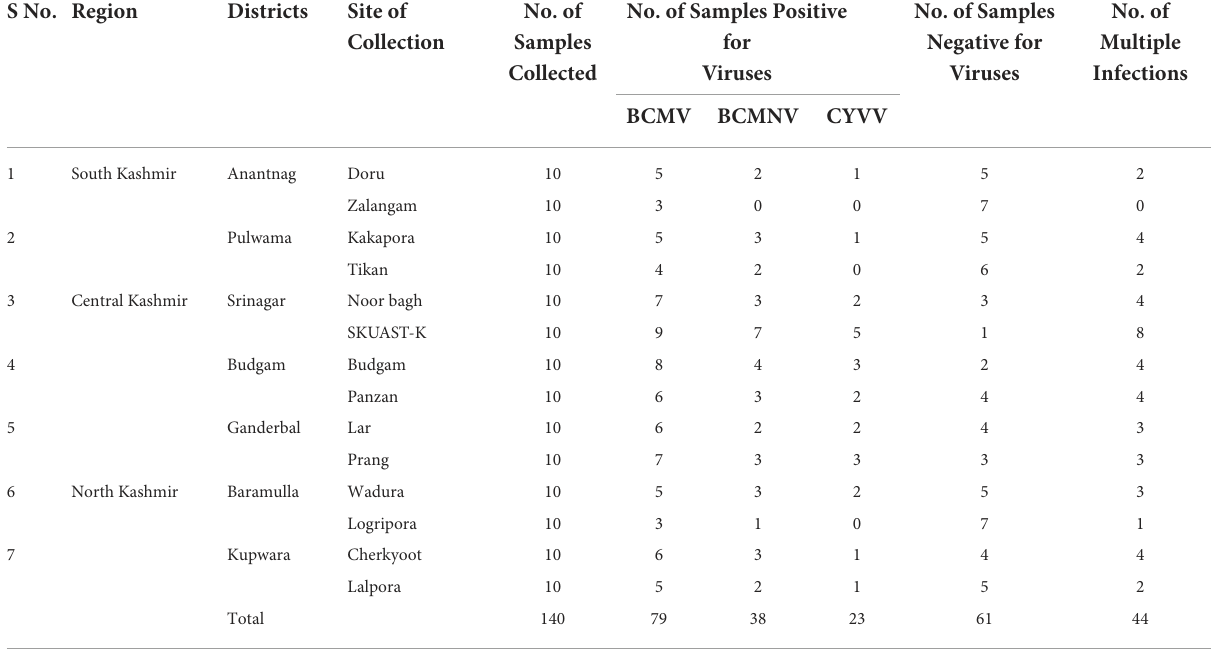
TABLE 3 Distribution of viruses in Kashmir using RT-PCR. S No. Region